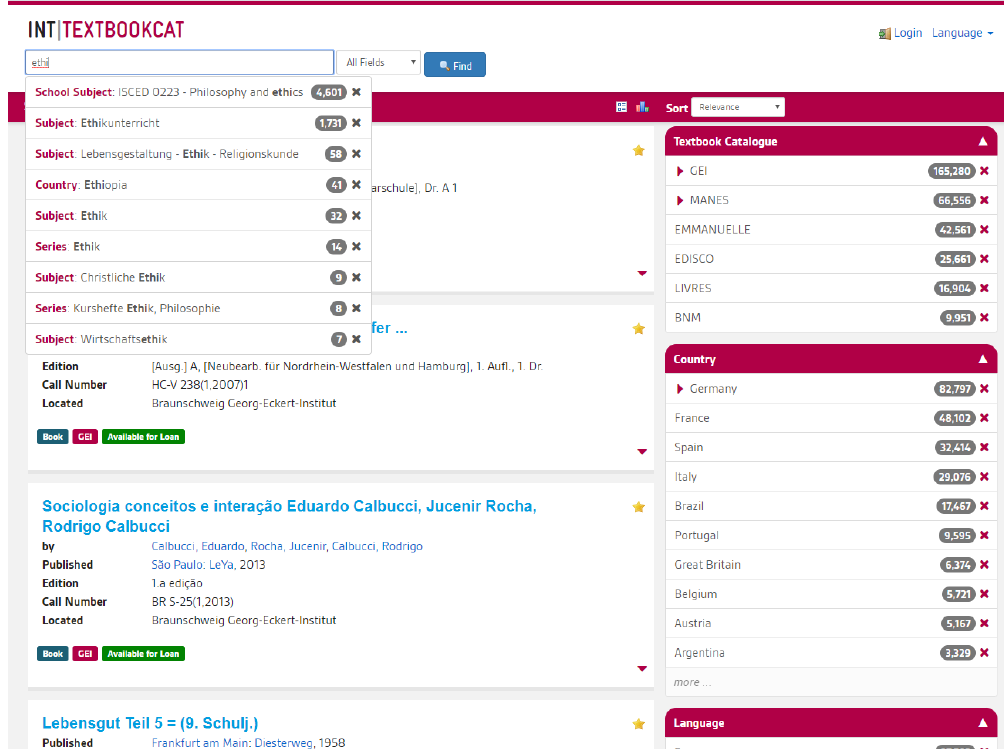
Figure 3. Screenshot of the International TexbookCat Research